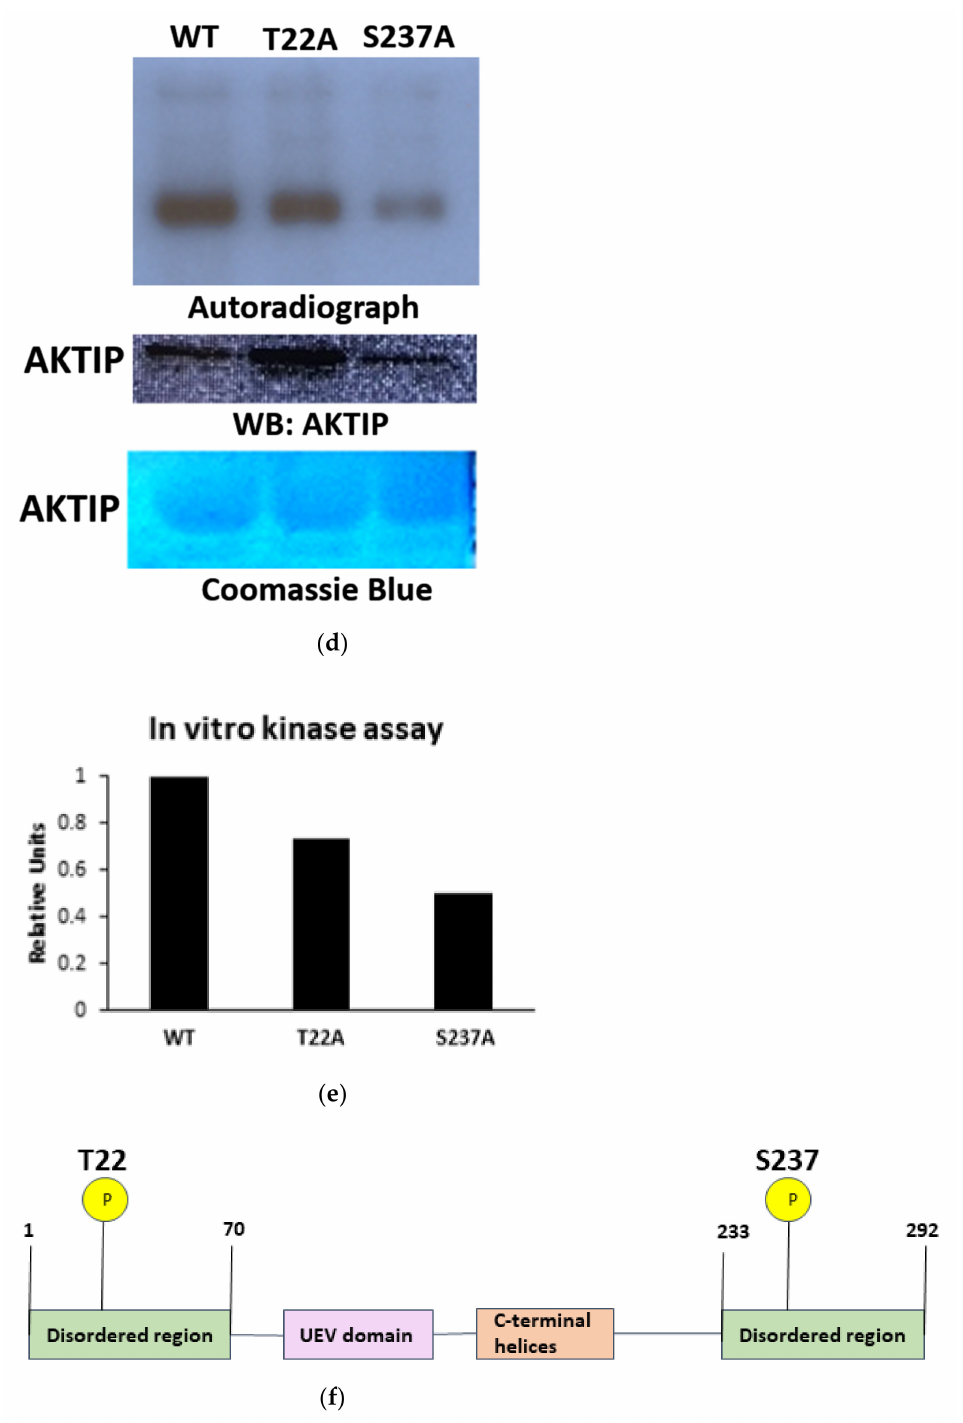
Figure 2. TLK1 phosphorylates AKTIP at T22 and S237. ( a ) AKTIP phosphopeptide determination by MS in control AKTIP (top panel) and TLK1B+ AKTIP samples (bottom panel). The unique phosphorylated residues in TLK1B+ AKTIP samples are marked by red circles. ( b ) Peptides containing unique phosphorylated sites detected in the TLK1B+AKTIP samples with their corresponding MOWSE scores. ( c ) Spectral analysis of AKTIP phosphoresidues T22 and S237 determination by MS. ( d , e ) In vitro phosphorylation of wild-type and mutant GST-AKTIP proteins by TLK1B and densitometric quantitation of the bands relative to amounts, as determined by WB. ( f ) Graphical outline of AKTIP domain structure and location of the phosphorylated